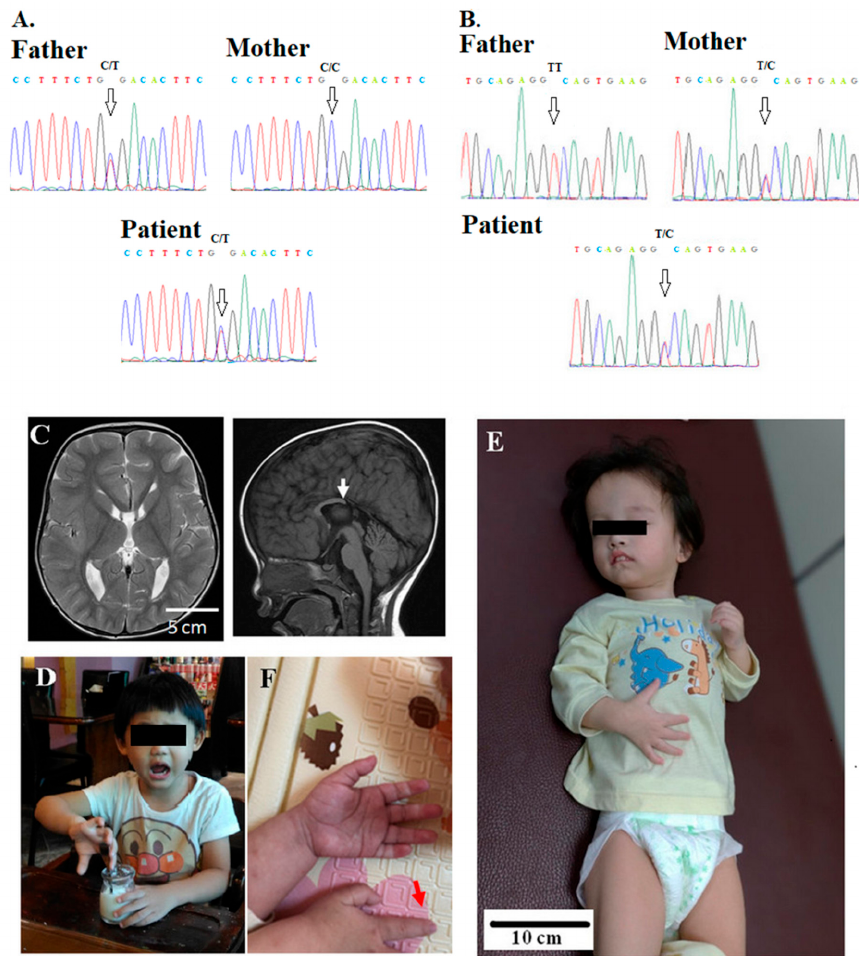
Figure 1. Patient 21 has compound heterozygous mutations of SZT2 , ( A ) c.C9055T (p.Arg3019Ter) (arrows) and ( B ) c.1496 + 2T > C (arrows), from the asymptomatic father and mother, respectively. Seizure onset occurred at 6 months old. His electroencephalogram shows developmental epileptic encephalopathy with multifocal epileptiform discharges. ( C ) The MRI shows a short and thick corpus callosum with missing of selenium (arrow). ( D ) Normal child with the same age demonstrates for comparison with patient. ( E ) Her examination was notable for macrocephaly, dysmorphic features, frontal bossing, hypertelorism, microphthalmia, depressed nasal bridge, long-tapered fingers, and hyperextensible joints. ( F ) Long-tapered fingers in the patient (red arrow).